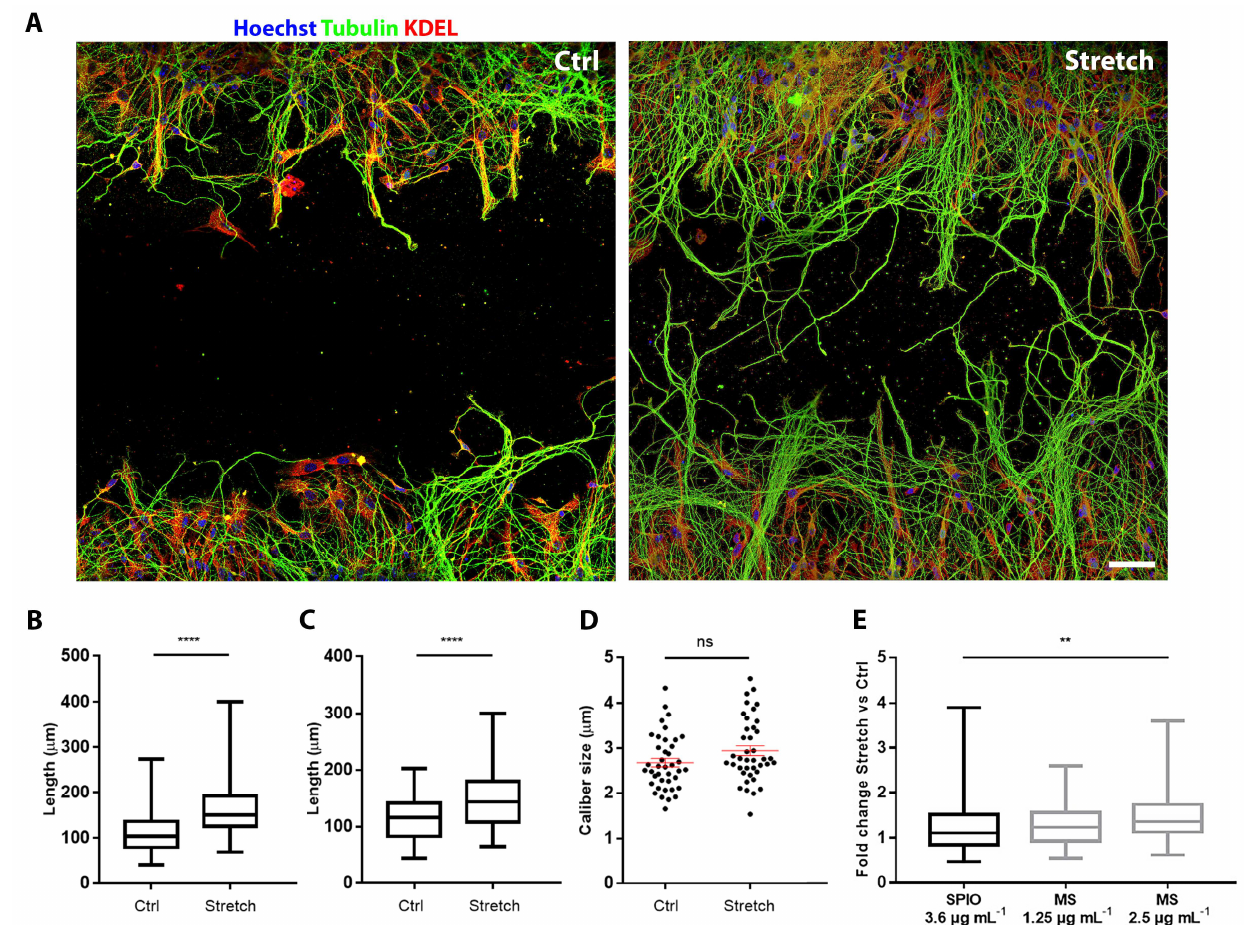
Figure 3. Stretch-growth assay. ( A ) Length of primary axons in control (left) and stretched condition (right), scale bar: 50 µ m. ( B ) Length of primary axons of neurons treated with 1.25 µ g Fe mL − 1 of magnetosomes (box plot, min-to-max); n = 120 from four independent assays. T -test for unpaired data, p < 0.0001, t = 5.881, df = 238. ( C ) Length of primary axons of neurons treated with 2.5 µ g Fe mL − 1 of magnetosomes (box plot, min-to-max); n = 120 from four independent assays. T -test for unpaired data, p < 0.0001, t = 8.152, df = 238. ( D ) Axon caliber of neurons treated with 2.5 µ g mL − 1 of magnetosomes (scatter dot plot, mean ± SEM). T -test for unpaired data, n = 40 from four independent assays, p = 0.07, t = 1.817, df = 78. ( E ) Comparison between fold change of axon length in stretched versus non-stretched conditions of samples treated with 3.6 µ g Fe mL − 1 of SPIONs, with 1.25 µ g mL − 1 of magnetosomes (MS) and 2.5 µ g mL − 1 MS (box plot, min-to-max); one-way ANOVA test, n = 120 neurons from four independent assays, p =